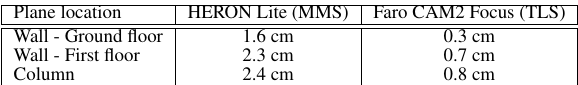
Table 1. RMS of the residuals after plane fitting. These values give an indication of the sensors noise.